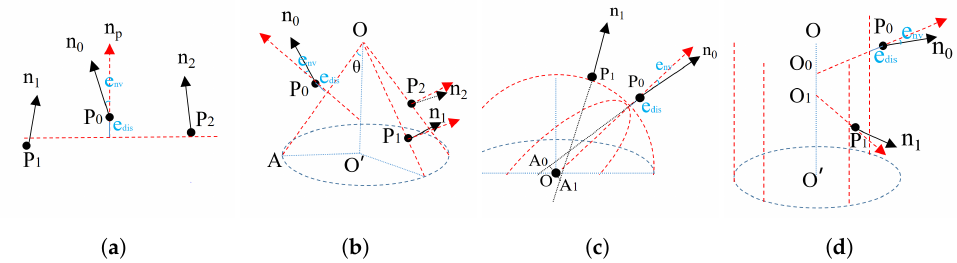
Figure 3. Definition of different shapes and the required samples. P 0 is the gravity center of the target voxel and P k is that of its random neighbors, n p and n k are the normal vectors, and e dis and e nv are the observation errors regarding point-to-shape distance and normal difference: ( a ) plane, ( b ) cone, ( c ) sphere, ( d )